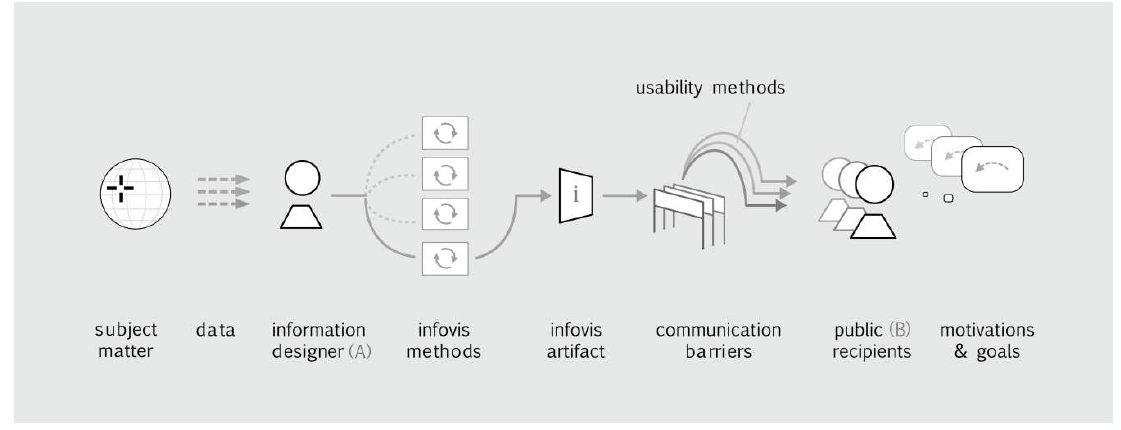
Figure 1: A Visual Communication Model